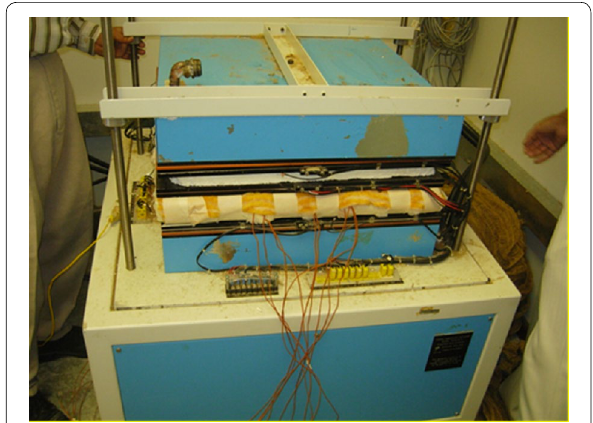
Fig. 2 Guarded hot plate for measuring the thermal conductivity of the concrete.